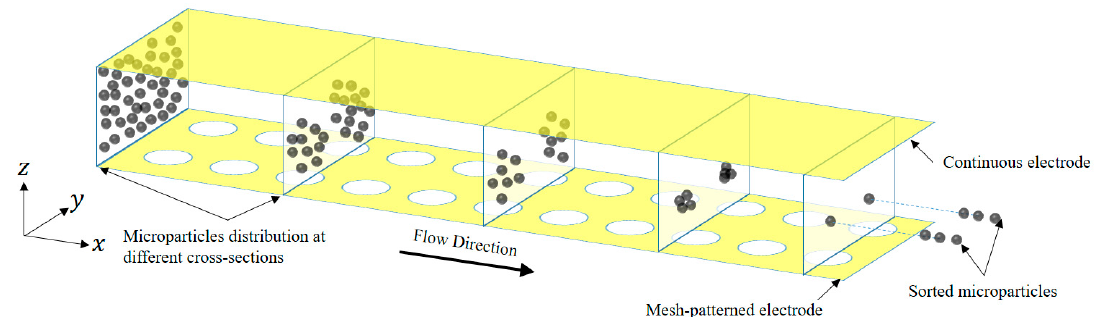
Figure 1. Schematic of the microfluidic device showing the distribution of microparticles at different cross-sections along the channel. The microchannel has one continuous electrode on top surface and a mesh-patterned electrode on the bottom part of the channel. Yellow color represents the electrodes.